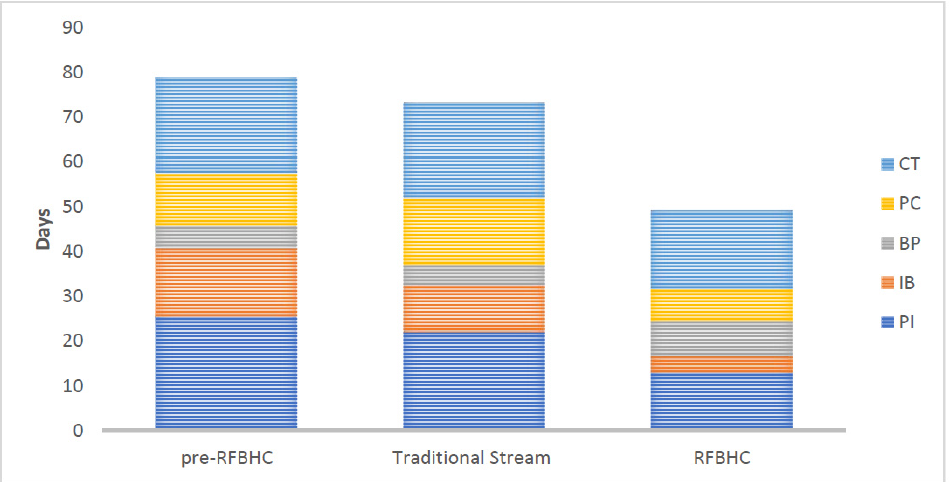
Figure 4. Secondary mean wait-time endpoints: presentation to diagnostic imaging (PI), diagnostic imaging to biopsy (IB), biopsy to pathology (BP), pathology to consult (PC), and consult to initial treatment (CT) for each study